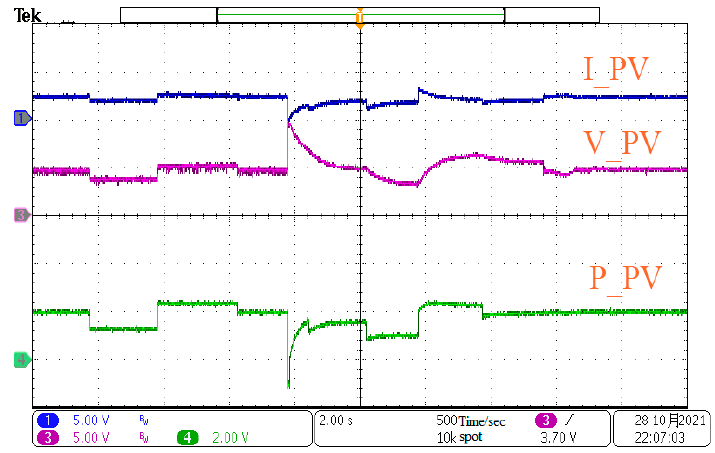
Figure 22. The radiations scenario, power load, and the DC-link voltage output under constant load and radiation changes. Figure 24. The battery’s current, voltage, and power under load constant and radiation changes.